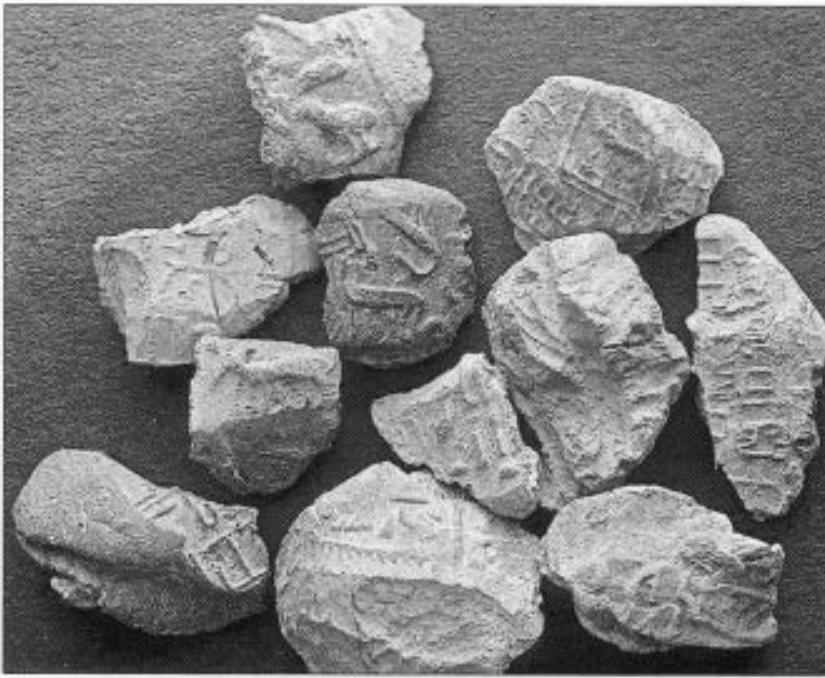
Figure 3 Mud sealings were used to seal documents, jars, doors, etc. They often record information in the form of hieroglyphs such as the names of kings (which provide useful dating evidence), the contents of the object being sealed, or the destination of the sealed